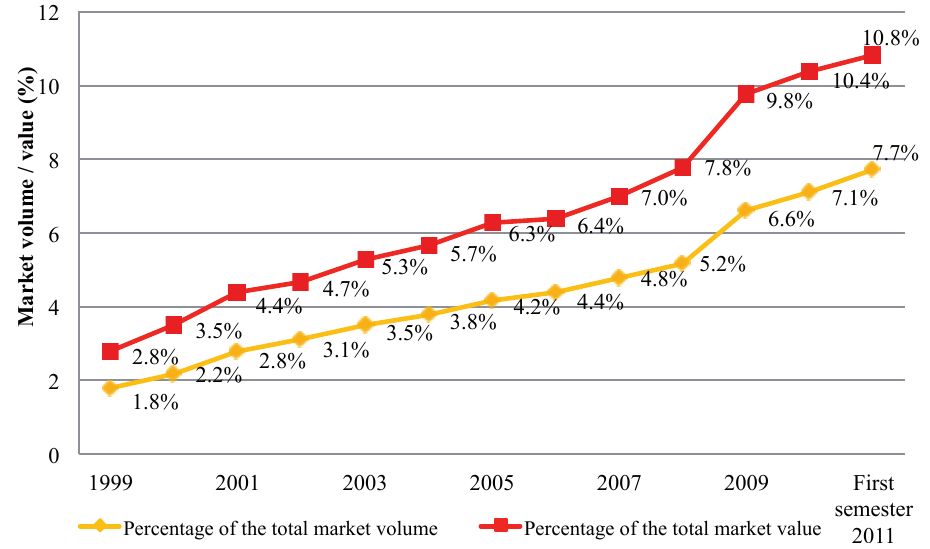
Figure 8. Share of organic milk in total retail sales of milk in France (%; 1999-2007)